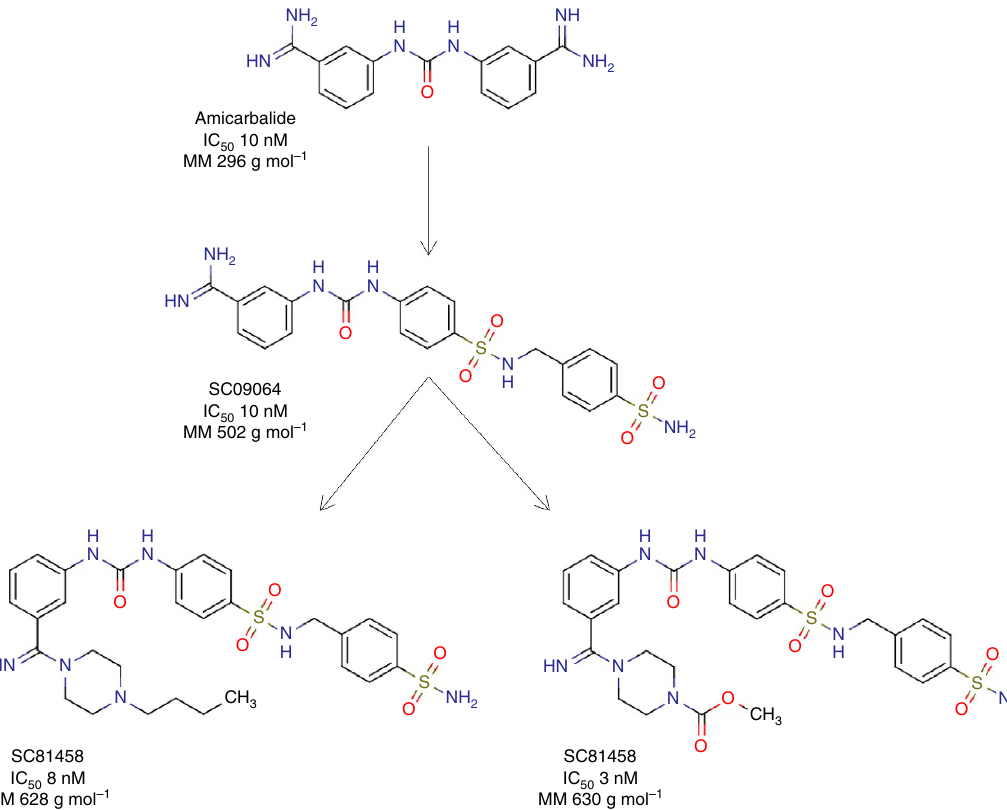
Figure 1 | Structures and in vitro activities of hit and lead compounds. The names of the compounds, their half maximal inhibitory concentrations (IC 50 ), and their molecular masses are